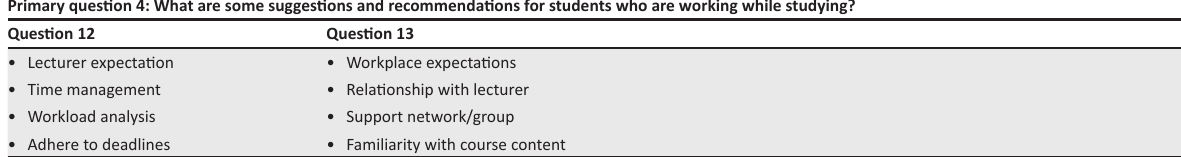
TABLE 2d: Interviewees’ coded